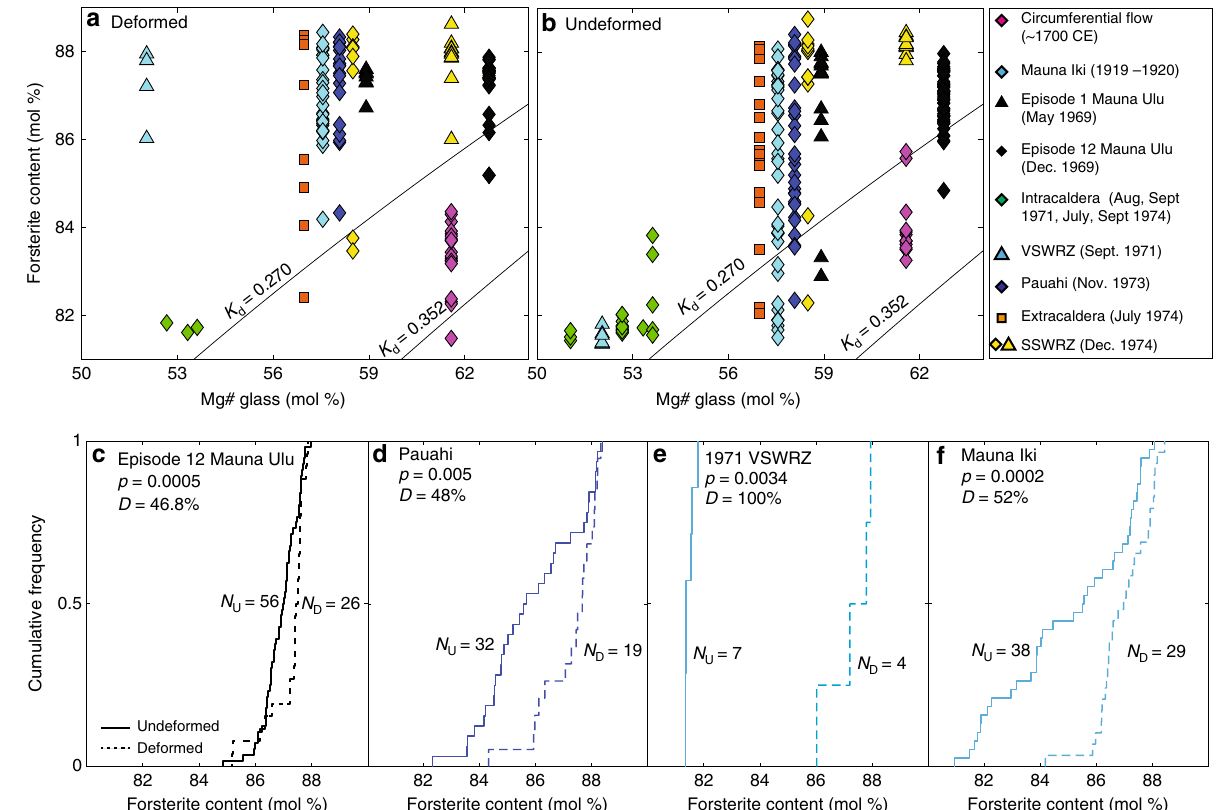
Fig. 5 Chemical differences between deformed and undeformed K ī lauean olivine grains. a , b Olivine forsterite contents (mol%) vs. matrix glass Mg# (Fe 3 + /Fe T = 0.15; ~QFM; see ref. 84 ). Olivine-liquid equilibrium lines are shown for K D = 0.270 – 0.352 (ref. 85, 86 ). Both deformed and undeformed grains have higher forsterite contents than the equilibrium olivine composition of their matrix glasses. However, deformed grains show a narrower range of forsterite contents, which lie further from the equilibrium fi eld than undeformed grains. c – f Cumulative distribution functions comparing undeformed (solid lines) and deformed (dashed lines) olivines for four eruptions. Deformed grains are more primitive at a statistically signi fi cant level ( p < 0.01) using the two sample Kolmogorov-Smirnov test. The test statistic D (representing the distance between the two distributions) is also shown. SSWRZ, seismic South West Rift Zone; VSWRZ, volcanic South West Rift